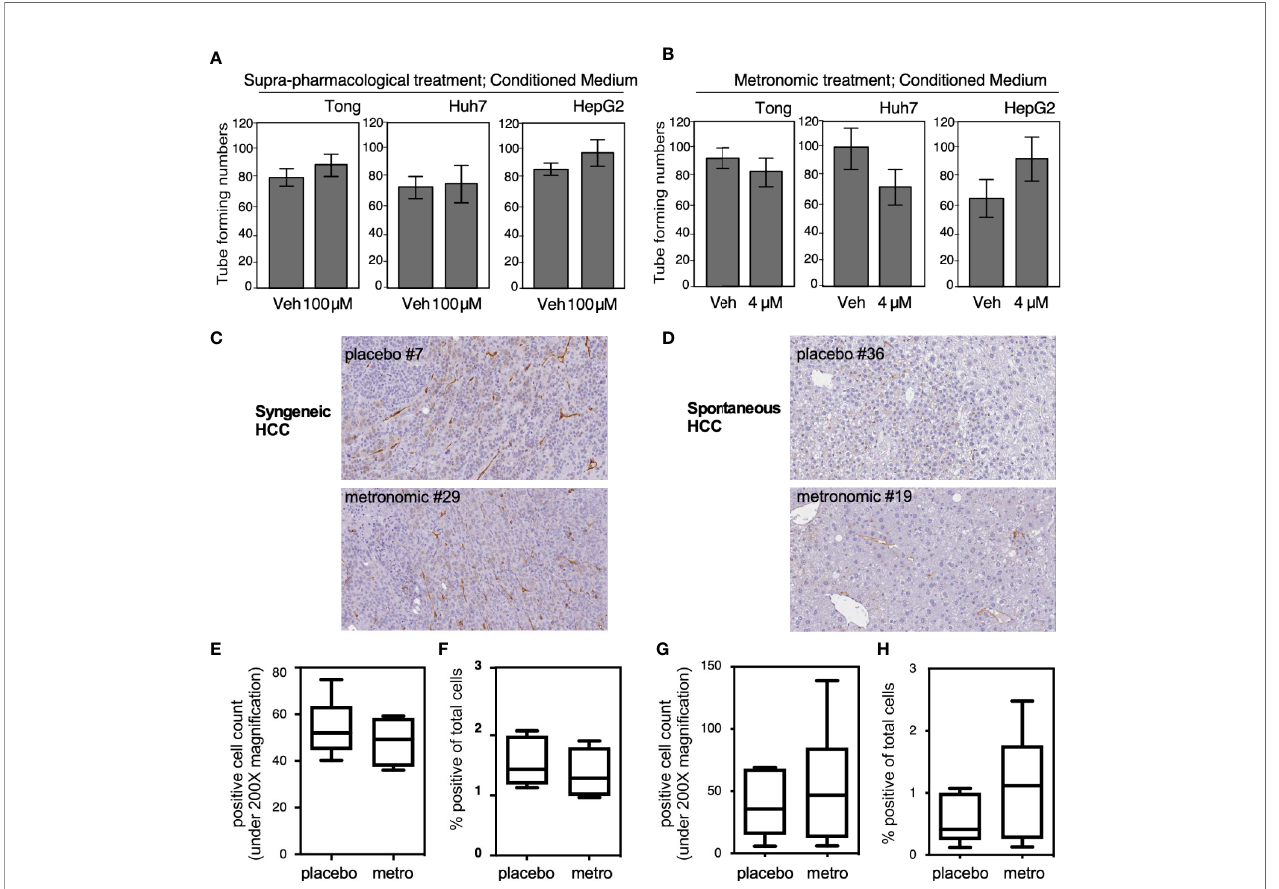
FIGURE 5 | Microenvironmental in fl uence from the HCC cells treated with metronomic Celecoxib did not alter the angiogenenesis phenotype. (A, B) Three HCC cell types (Tong, Huh7, and HepG2) were treated with suprapharmacological [ (A) 100 m M for 2 days] or metronomic Celecoxib [ (B) 4 m M, 7 days] and the conditioned medium (CM) was harvested. Each CM was then applied onto umbilical cord-derived endothelial cells to observe the angiogenic capacity of the CM. The tube- forming number was counted as described in materials & methods section, and quantitation result was plotted with standard error from three independent experiments. (C, D) Micro-vessel densities determined by CD34 IHC staining in comparable-sized HCCs from either syngeneic HCC models or spontaneous HCC models. Micro-vessel densities expressed by CD34+ cell counts (E) and percentage of CD34+ area to total scanned area (F) were comparable between the “ metronomic Celecoxib ” group and the placebo group in syngeneic HCC model. (G, H) a similar fi nding was also noticed in the spontaneous HCC